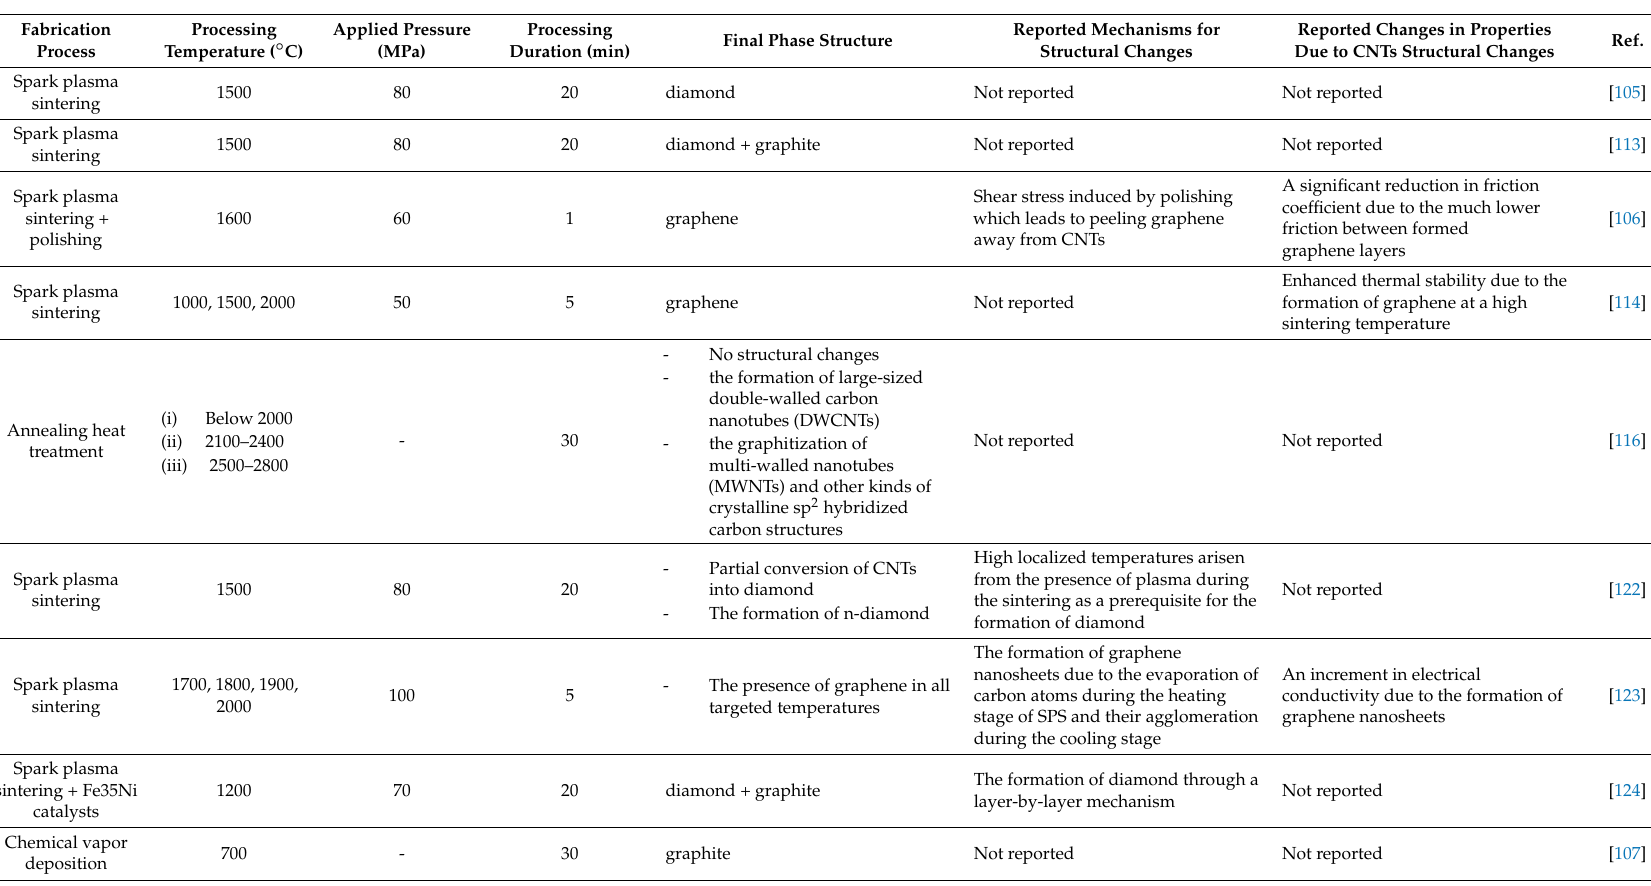
Table 2. Overview over a variety of conventional manufacturing techniques, allowable processing windows and structural changes of pure CNTs and their effects on the physicomechanical properties of